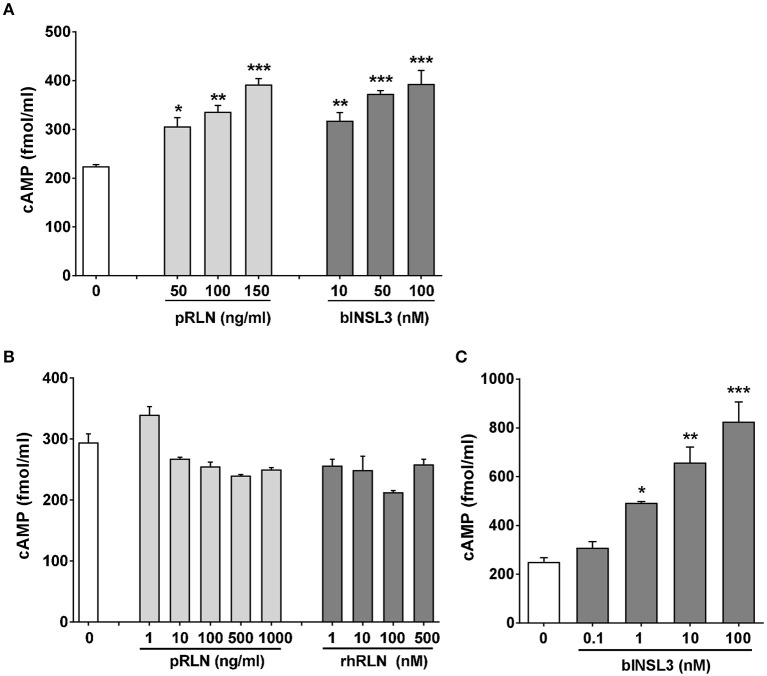
Primary cultures of purified bovine myometrial (A) or theca cells (B,C) stimulated or not for 20 min with various concentrations of porcine relaxin (pRLN), human recombinant relaxin (rhRLN) or bovine INSL3 in the presence of the phosphodiesterase inhibitor IBMX at 1 mM, measuring cAMP production as endpoint. Significant difference from basal is indicated by asterisks (*p < 0.05; **p < 0.01; ***p < 0.001).